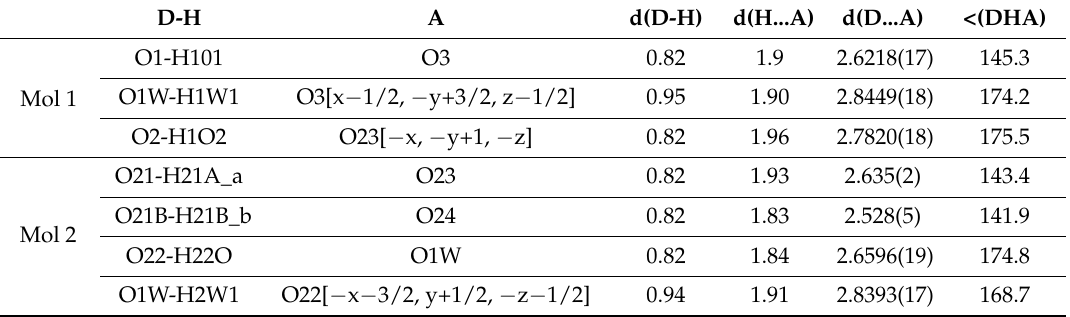
Table 4. Hydrogen bonds in CDHB molecules (given in Å and ◦